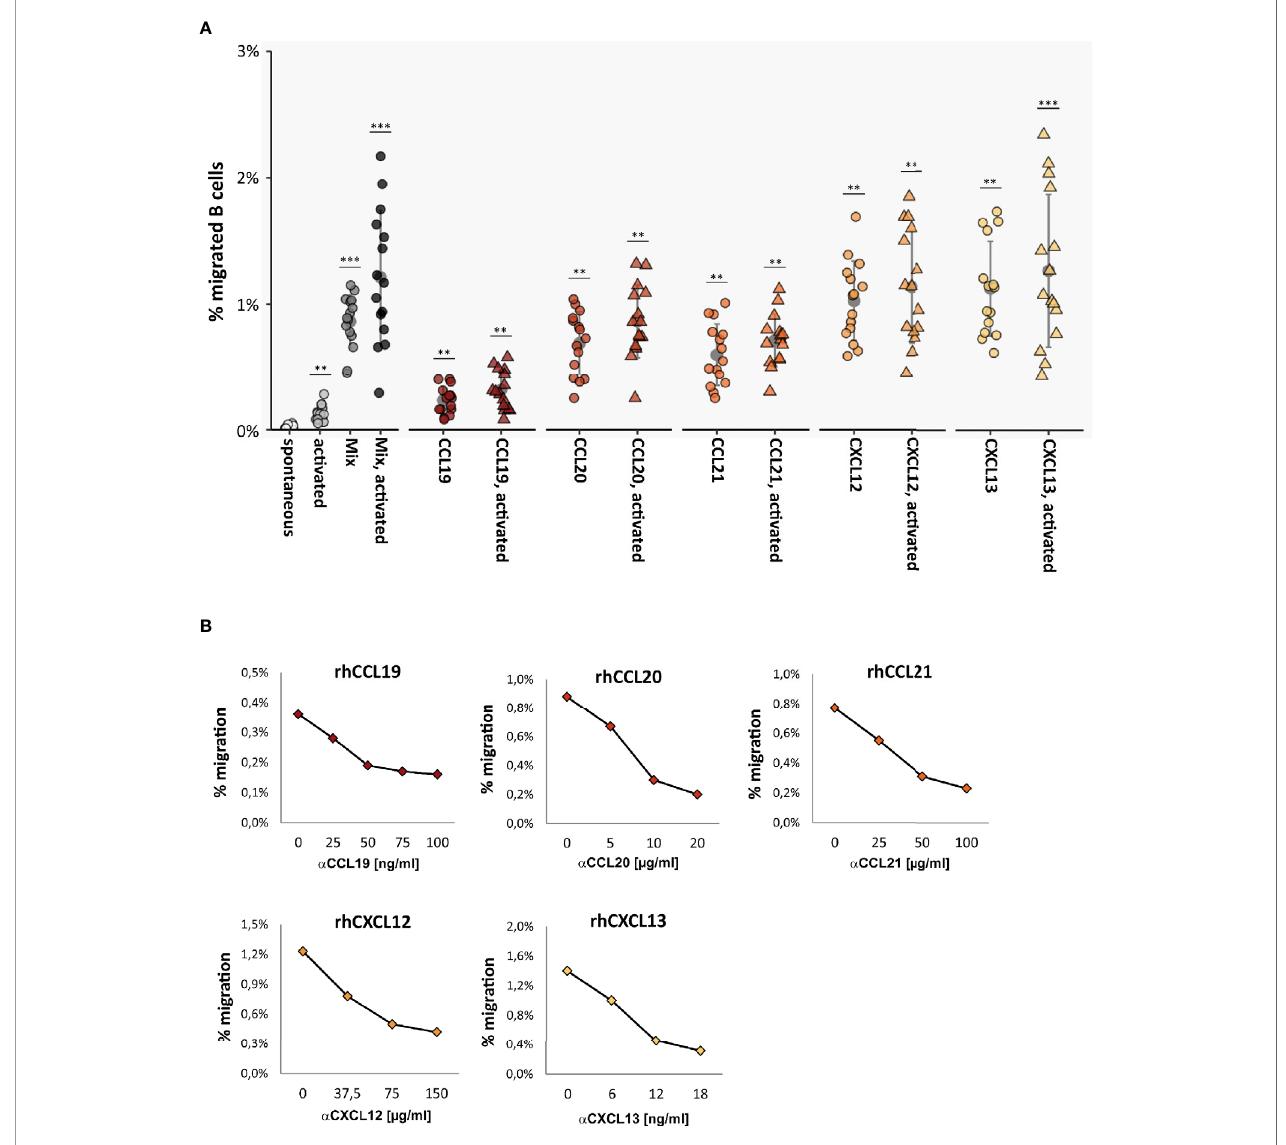
FIGURE 2 | Chemokine-induced transmigration of normal B cells across the HIBCPP monolayer. (A) TM rates of human total CD19 + B cells obtained from 15 healthy donors in the absence and presence of B-cell stimuli and chemokines. When various B-cell-speci fi c chemokines were added alone or in combination to the lower chamber, TM rates multiplied by approximately 50-fold, with CXCL12 and CXCL13 being most effective. TM rates were further enhanced (approximately 1.5-fold) when B cells were activated with anti-CD40 & IgM during chemokine-triggered migration. All experiments were carried out in triplicates. Dots represent data per individuals. Means are indicated (grey circles). Error bars denote SD. Asterices indicate statistical signi fi cances compared with spontaneous TM (*** P < 0.001, ** P < 0.01; one-way ANOVA plus post Hoc Tukey test). Chemokine concentrations: CCL19 [500 ng/ml], CCL20 [100 ng/ml], CCL21 [120 ng/ml], CXCL12 [100 ng/ml], and CXCL13 [1 µg/ml]. “ Mix ” = all chemokines; “ activated ” = CD40 mAb [5 µg/ml] & IgM [12.5 µg/ml]. (B) Blocking of chemotactic activities by neutralizing mAbs. TM rates of CD40/IgM-stimulated B cells towards indicated chemokines in the presence of increasing concentrations of neutralizing mAbs. All experiments were carried out in